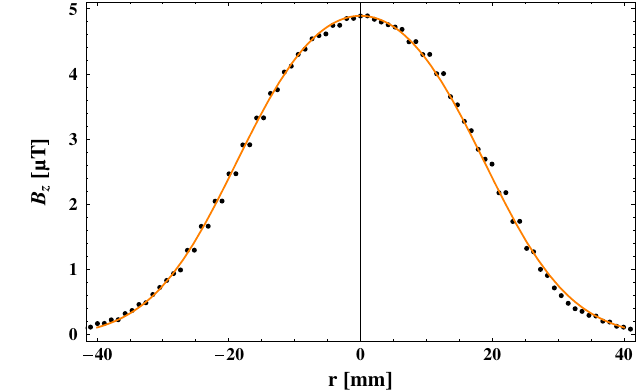
FIG. 4. Calculated magnetic field of a homogeneously magne- tized disk at the probe position compared to the measured trapped field as a function of